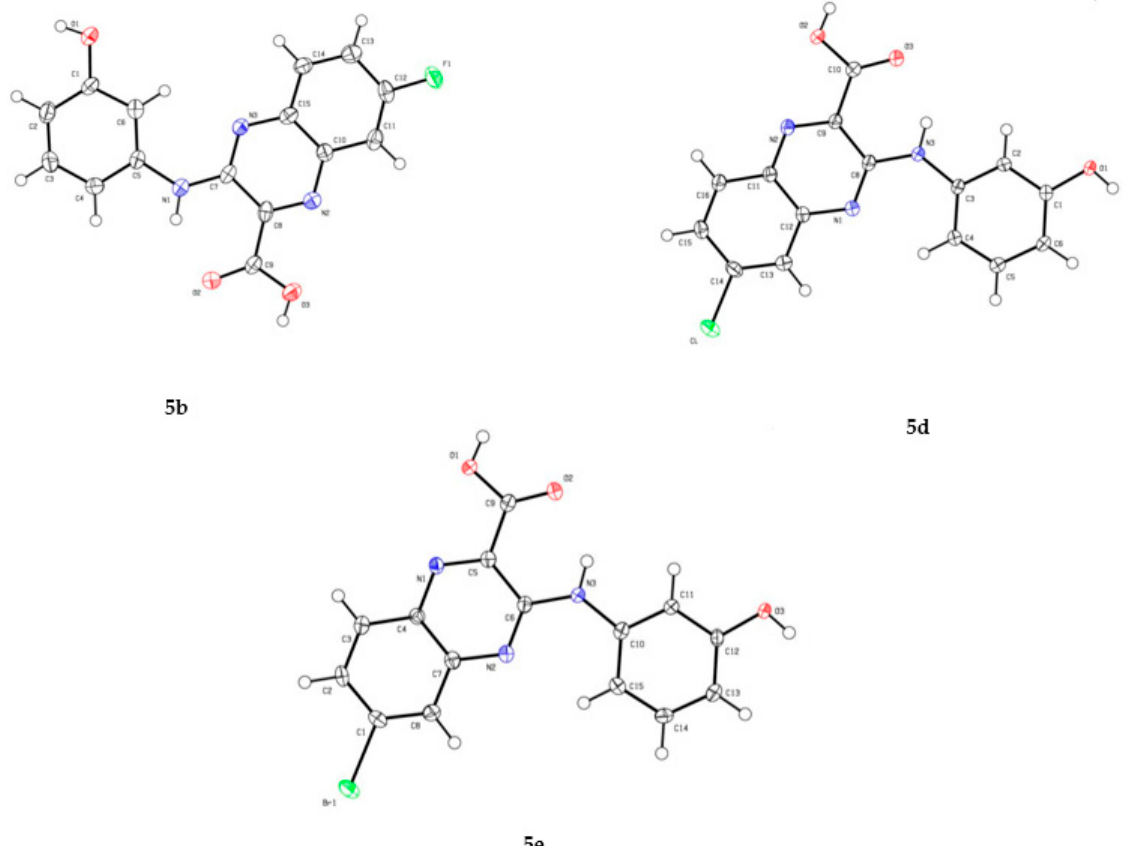
Figure 3. Oak Ridge Thermal-Ellipsoid Plot Program (ORTEP) drawing of substituted-quinoxaline-2-carboxylic acids 5b , 5d and 5e with thermal ellipsoids at 30% level [32].